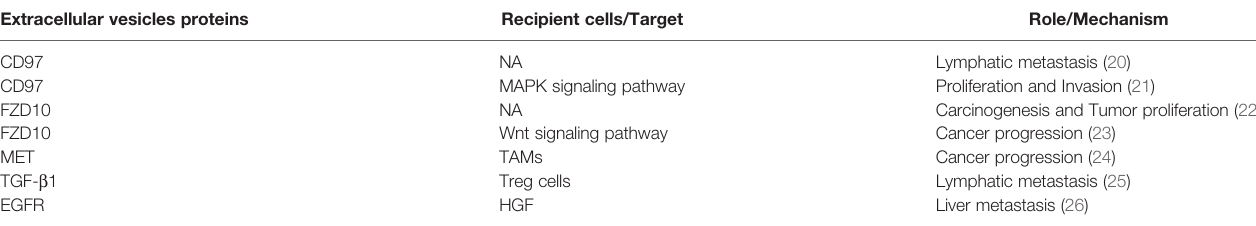
TABLE 1 | Summary of proteins in EVs involved in GC progression and metastasis. Extracellular vesicles